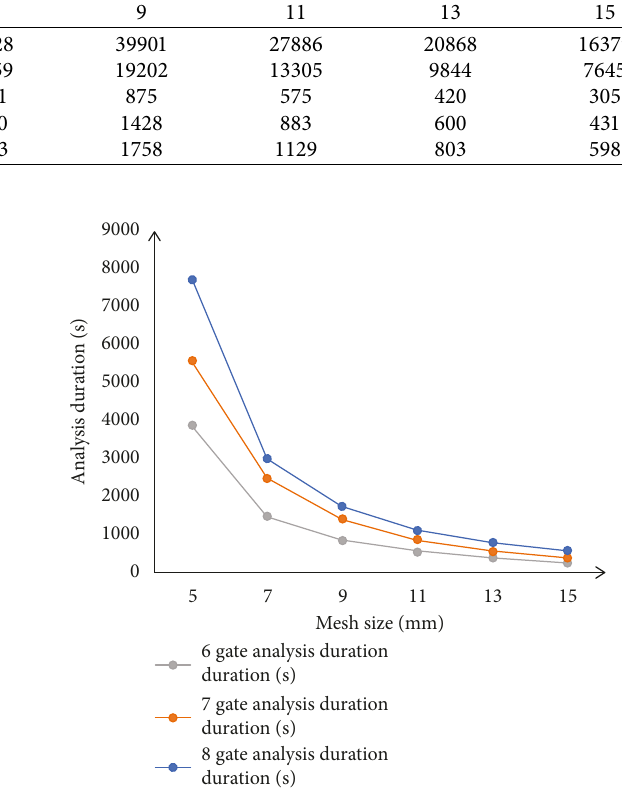
Figure 6: Mesh size and analysis time diagram.